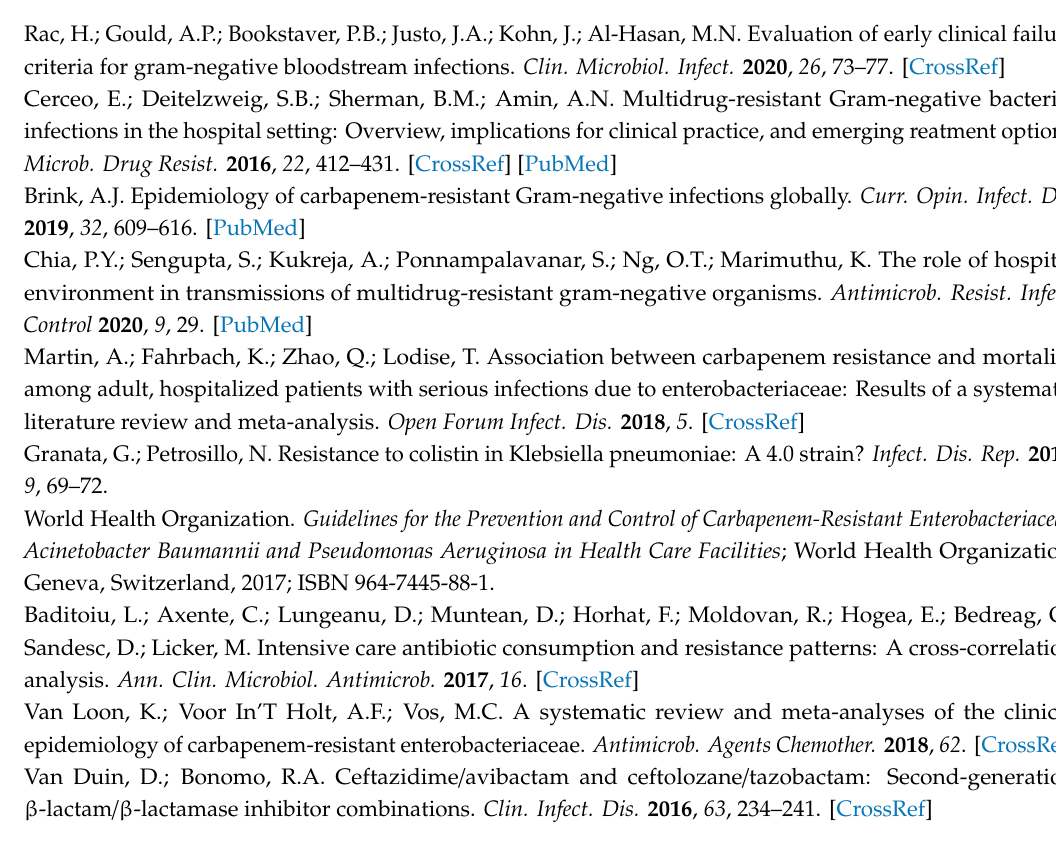
Figure A2. Frequency of the isolated microorganisms from group treated with ceftazidime/avibactam.